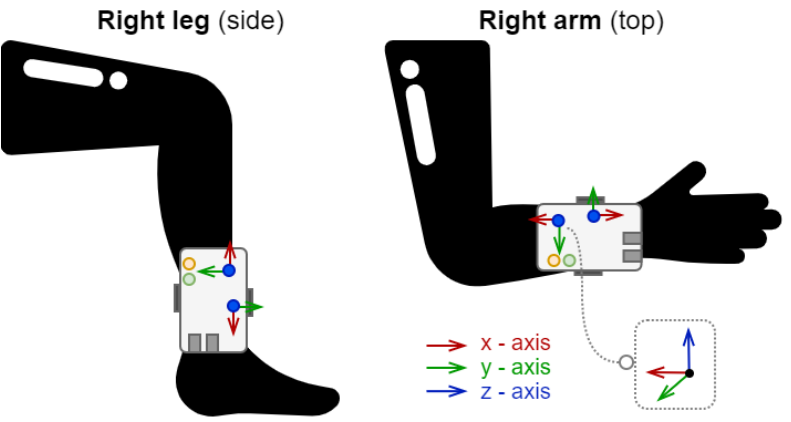
Figure 2. Location of wearable measurements devices on the body and orientation of the